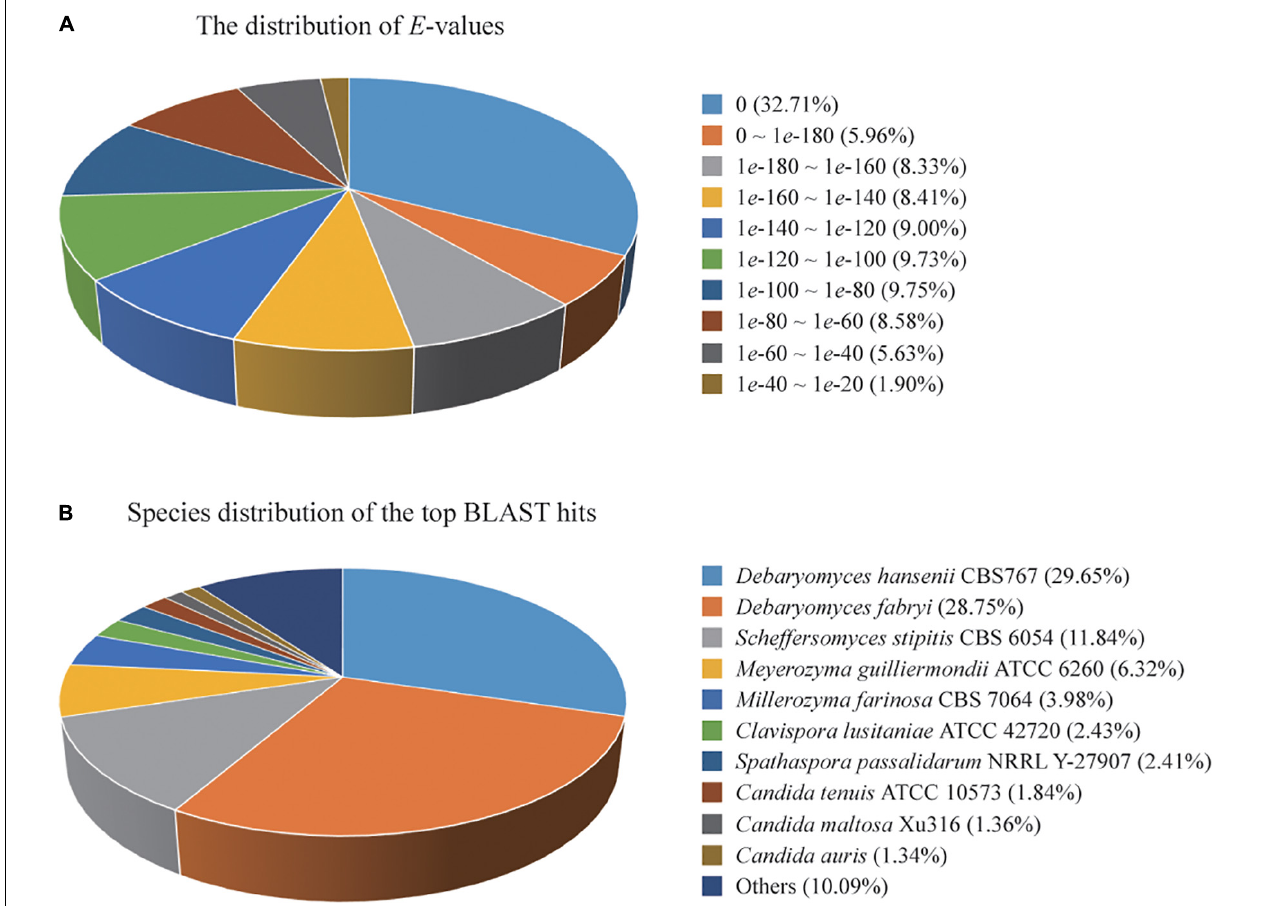
FIGURE 1 | (A) Percent distribution of E -value from the alignment of Candida oleophila predicted genes with available sequences in the nr database. (B) Species distribution of the top BLAST hits for the best alignment of C. oleophila predicted genes against the nr